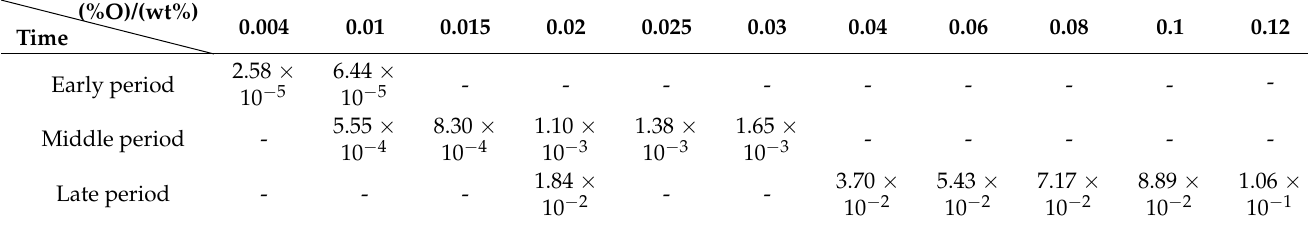
Table 9. Activities of [O] in molten steel in different scenes.